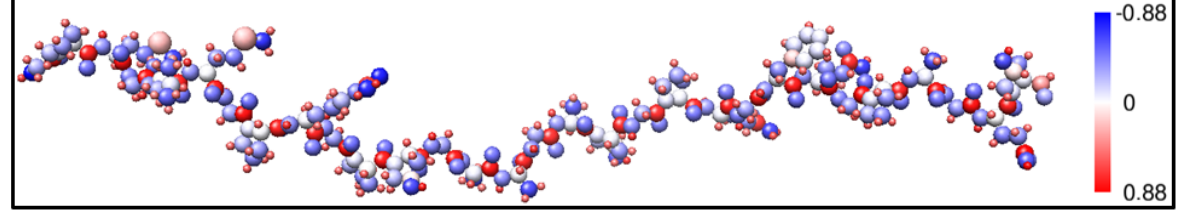
Figure 5. (Color on-line) Ball and stick model of a single strand α size of the atoms represented by their covalent radii. The color indicates the amount of charge transfer ( Q * , number of valence electrons) for each α